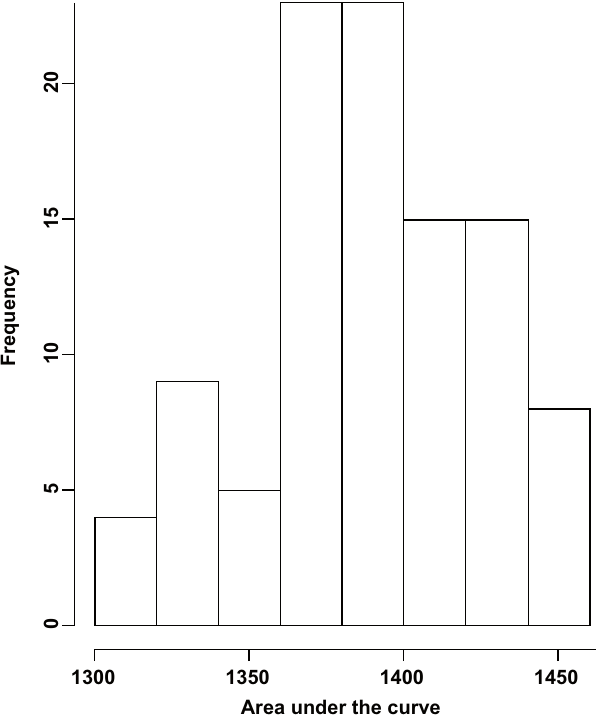
Figure 2. Distribution of duration of aneasthesia (minutes). Histogram of frequencies of the duration of aneasthesia in the included patients.